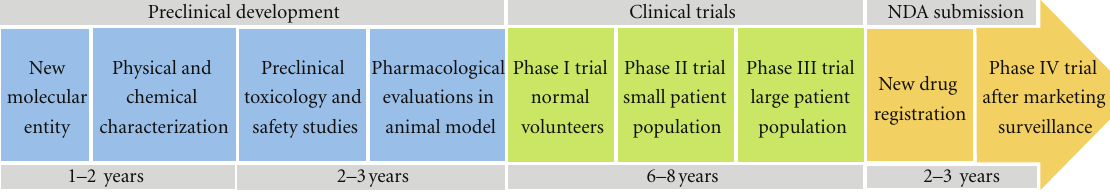
Figure 1: Schematic description of the stages required by the Food and Drug Administration (FDA) to reach the commercialization of a new drug application